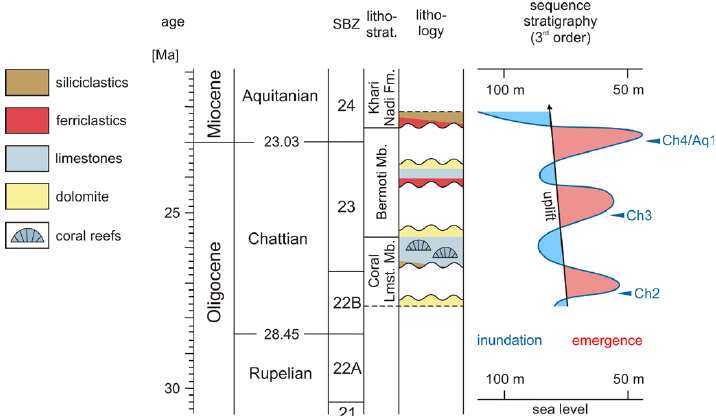
Fig. 4. Stratigraphic correlation of Bermoti River section with the shallow benthic foraminifera zones (SBZ) of Cahuzac and Poignant (1997), third-order sequences of Hardenbol et al. (1998) and global chronostratigraphy (Gradstein et al., 2012). Lithostratigraphy according to Biswas